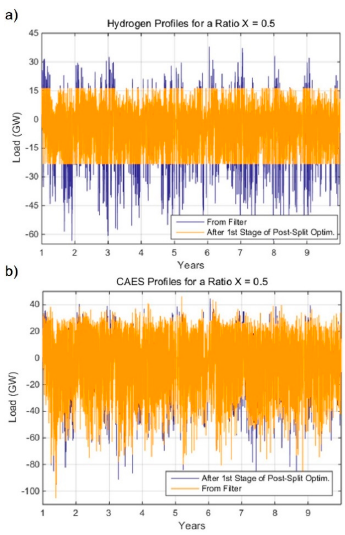
Figure 7. Comparison of work profiles for a ratio X = 0.5 after the sign-preserving filter and after post-split optimization. ( a ) Work profiles for hydrogen; ( b ) work profiles for CAES.